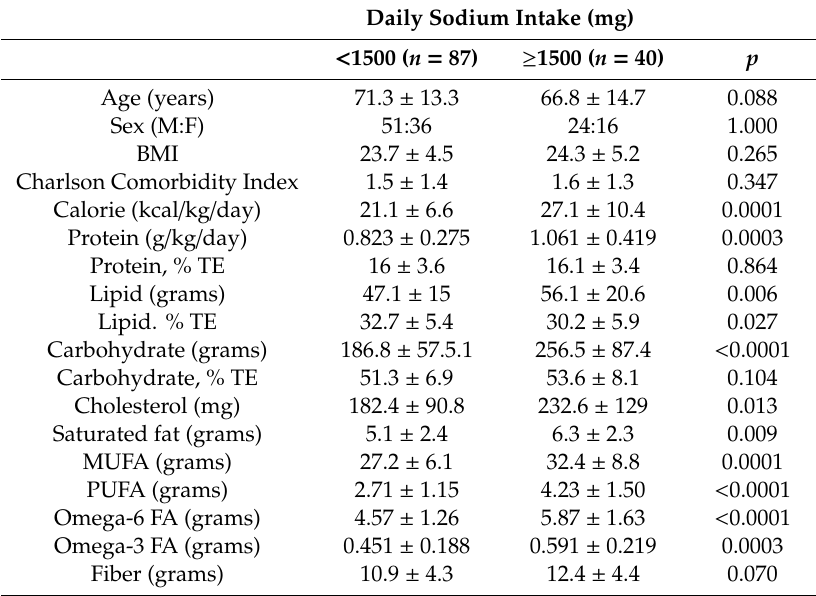
Table 2. Daily intake of calorie, protein, and fat according to the daily sodium intake.